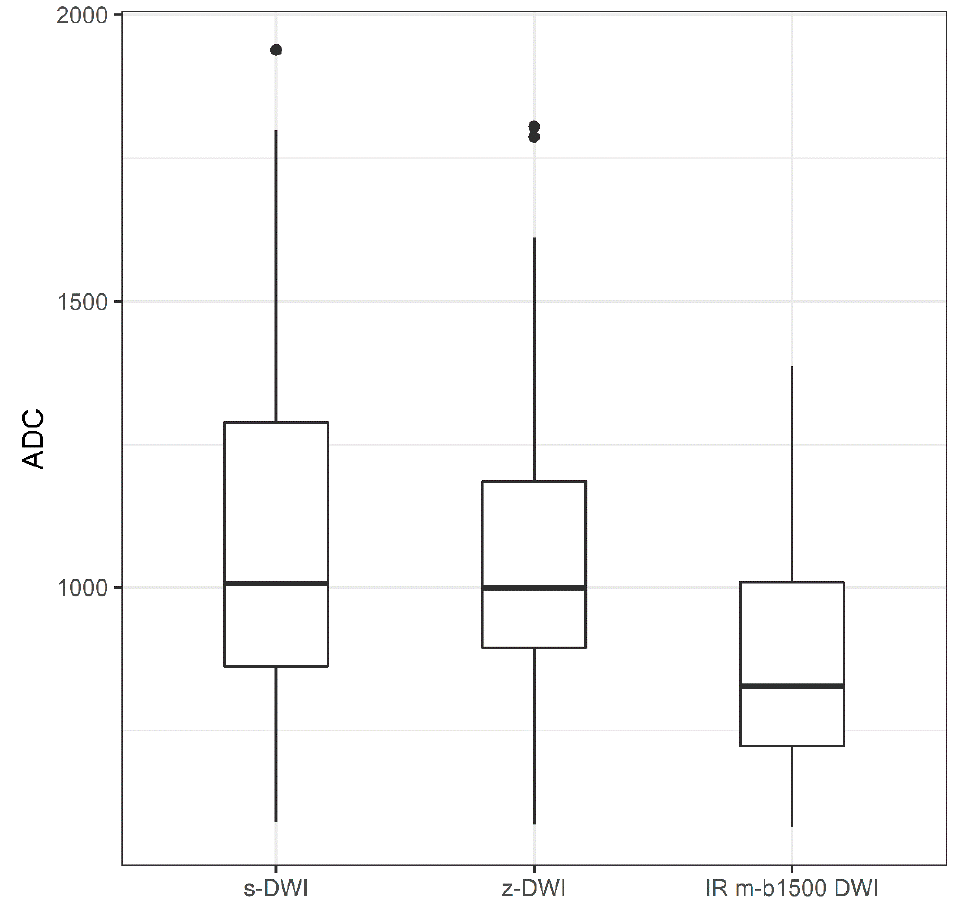
Figure 4. Boxplot of apparent-diffusion-coefficient (ADC) values of the single-shot echo-planar diffusion-weighted imaging (DWI) (s-DWI), zoomed DWI with spectral-attenuated inversion-recovery fat saturation (z-DWI), and improved inversion-recovery fat-saturation DWI (IR m-b1500 DWI)